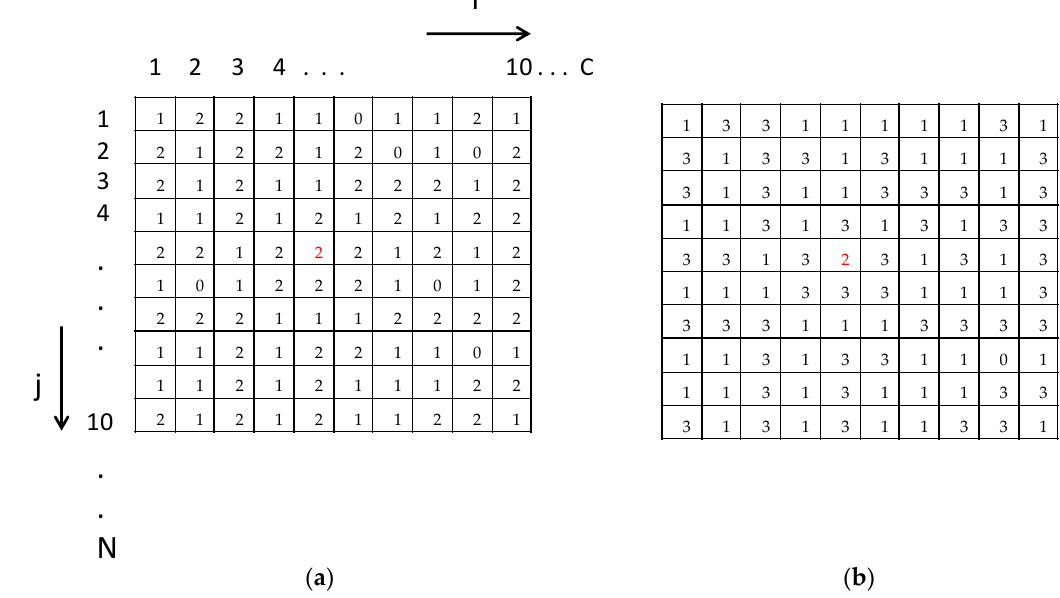
Figure 1. Cellular automata (CA) scheme used to model photo ‐ oxidation in molecularly doped polymers (MDPs). Row j = 1 represents the photo ‐ exposed film surface. The CA cell entries (0, 1, 2 or 3) are defined in the text. Portions of CA arrays are shown for c M = 50% and c O 2 = 5% for: ( a ) initial time